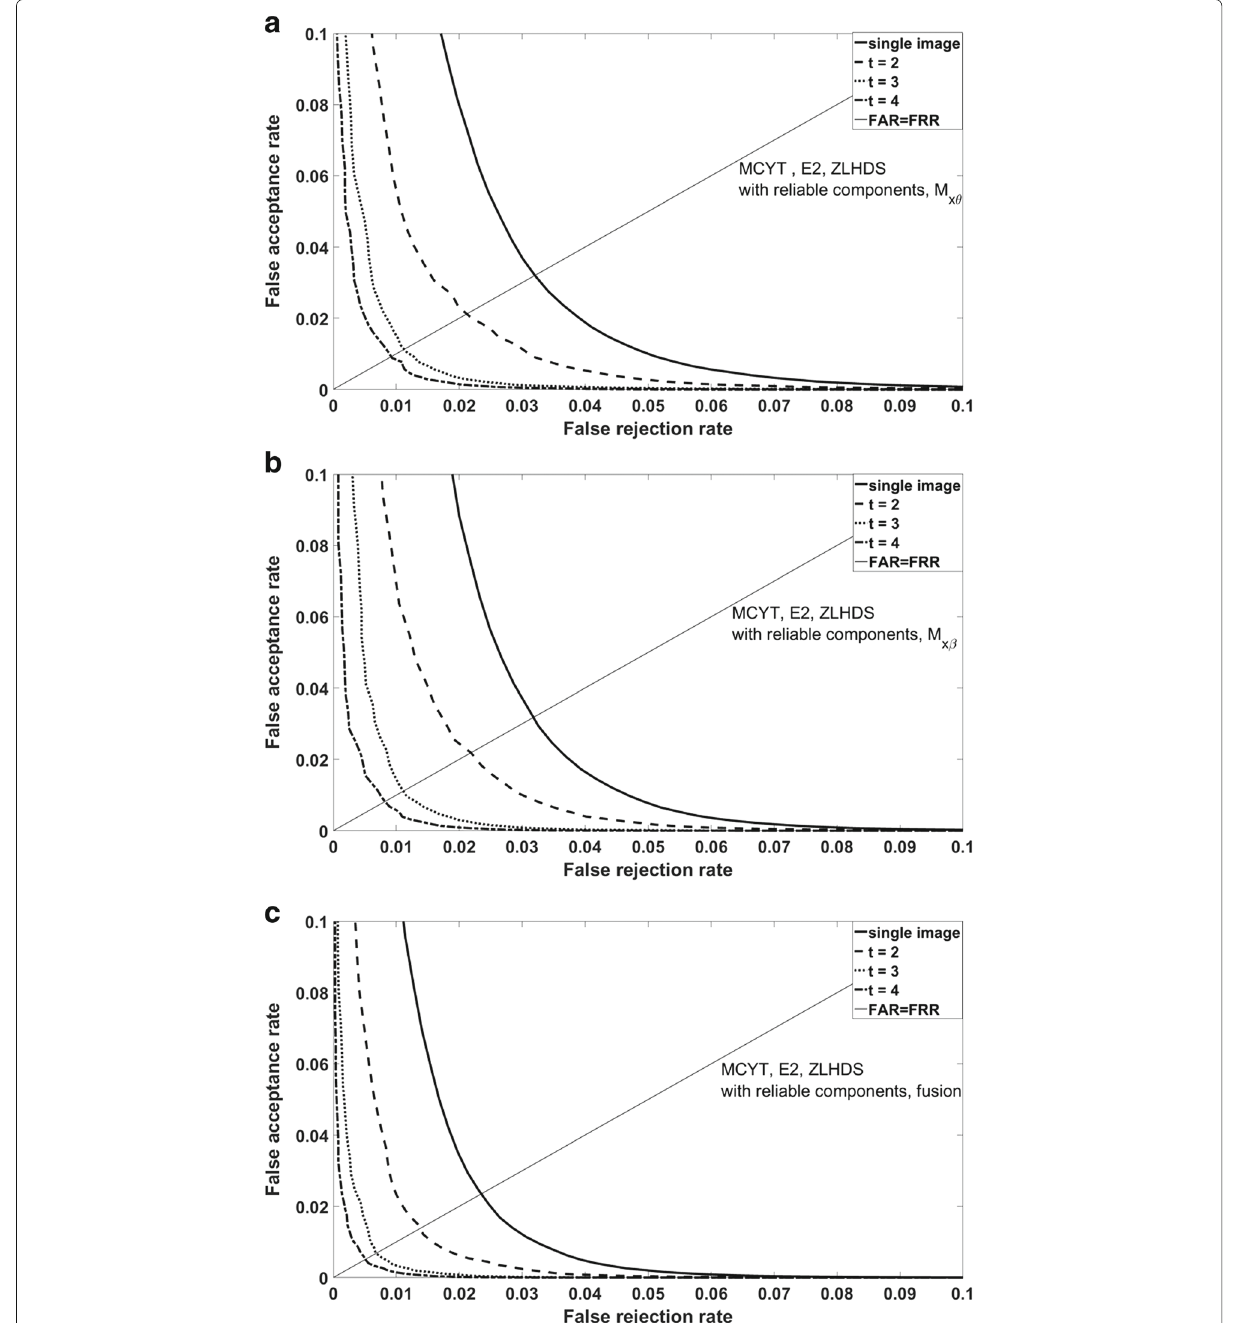
Fig. 11 Performance effect of the number of images used for enrollment